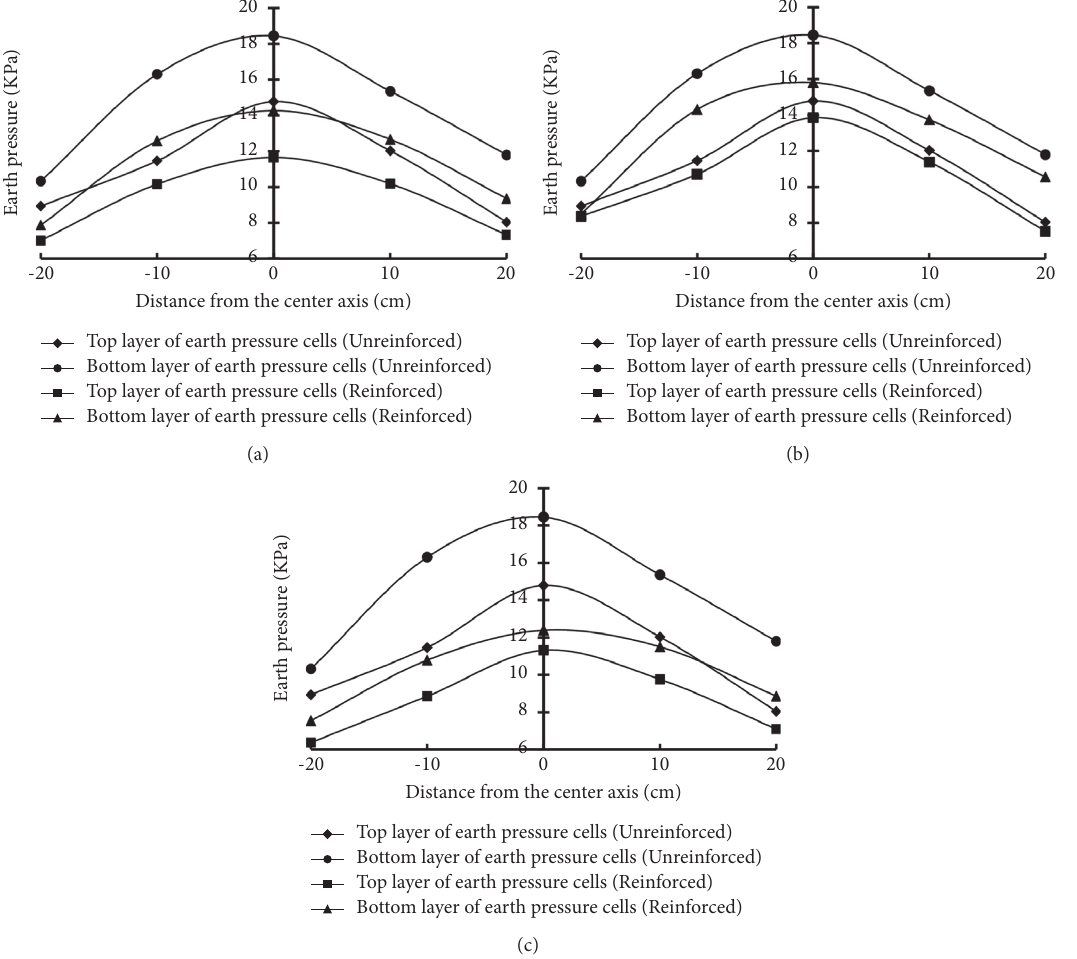
Figure 11: Earth pressures in trapezoidal filling structure. (a) Single top layer reinforced with tire slices. (b) Single bottom layer reinforced with tire slices. (c) Both top and bottom layers reinforced with tire